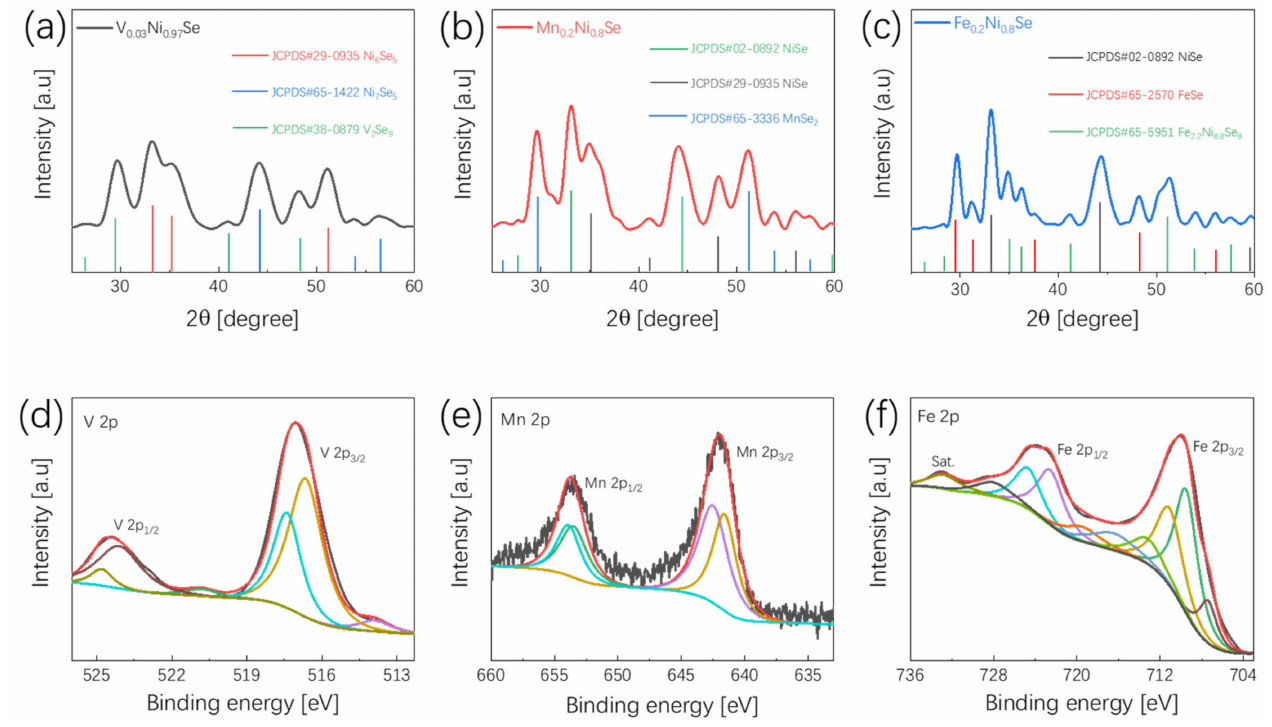
Figure 5. XRD patterns of ( a ) V 0.03 Ni 0.97 Se; ( b ) Mn 0.2 Ni 0.8 Se; and ( c ) Fe 0.2 Ni 0.8 Se. High-resolution XPS spectra of ( d ) V 2p; ( e ) Mn 2p; ( f ) Fe